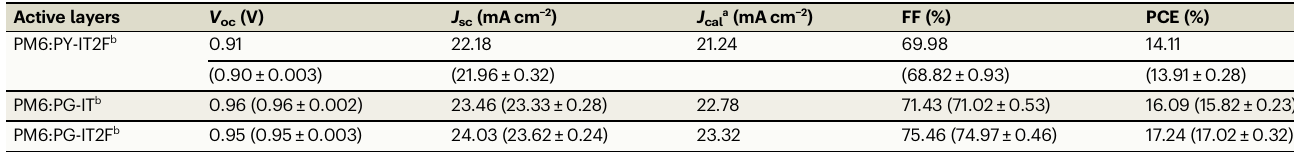
Table 2 | Photovoltaic parameters of the optimal all-PSCs based on PM6:PSMAs (1:1, w/w), measured under the illumination of AM1.5 G, 100 mWcm − 2 Active